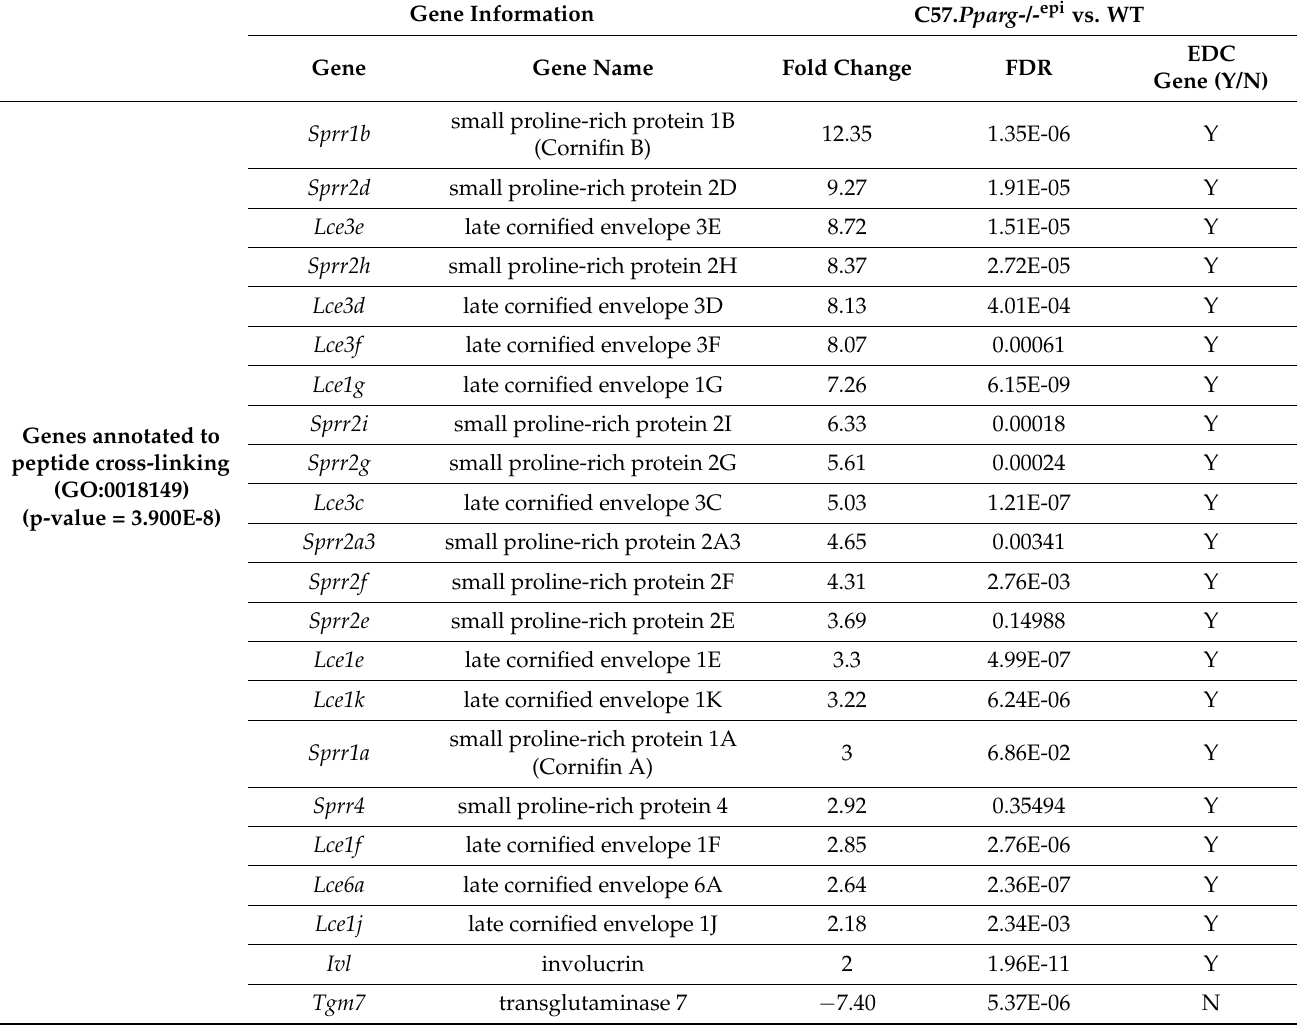
Table 3. Differentially expressed genes that are associated with GO groups for peptide cross-linking and keratinization. Gene Information C57. Pparg -/- epi vs. WT Gene Gene Name Fold Change FDR